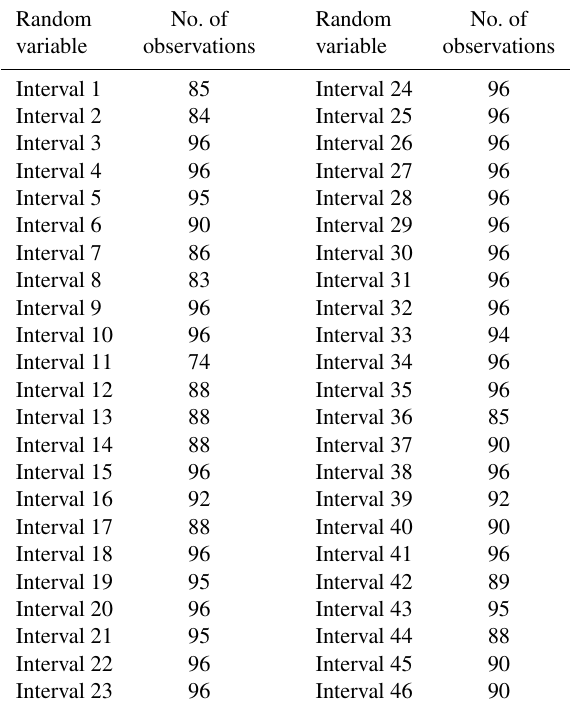
Table 3. Number of observations for every RV (named as interval). Random No. of Random No. of variable observations variable